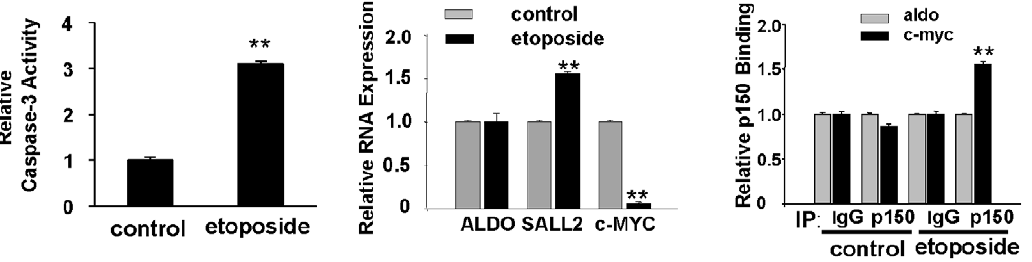
Figure 3. An apoptotic signal leads to increased binding of p150 to the c-MYC promoter. (A) Left - Etoposide-treated HOSE cells were monitored for apoptosis by caspase-3 activation. Middle - Quantitative RT-PCR shows a moderate increase in SALL2 and a large decrease in c-MYC expression following etoposide treatment. Right - ChIP followed by qRT-PCR shows increased binding of p150 to the c-MYC promoter in etoposide- treated cells. All histograms are based on triplicate determinations. ** denotes p , 0.01 comparing means of experimental and